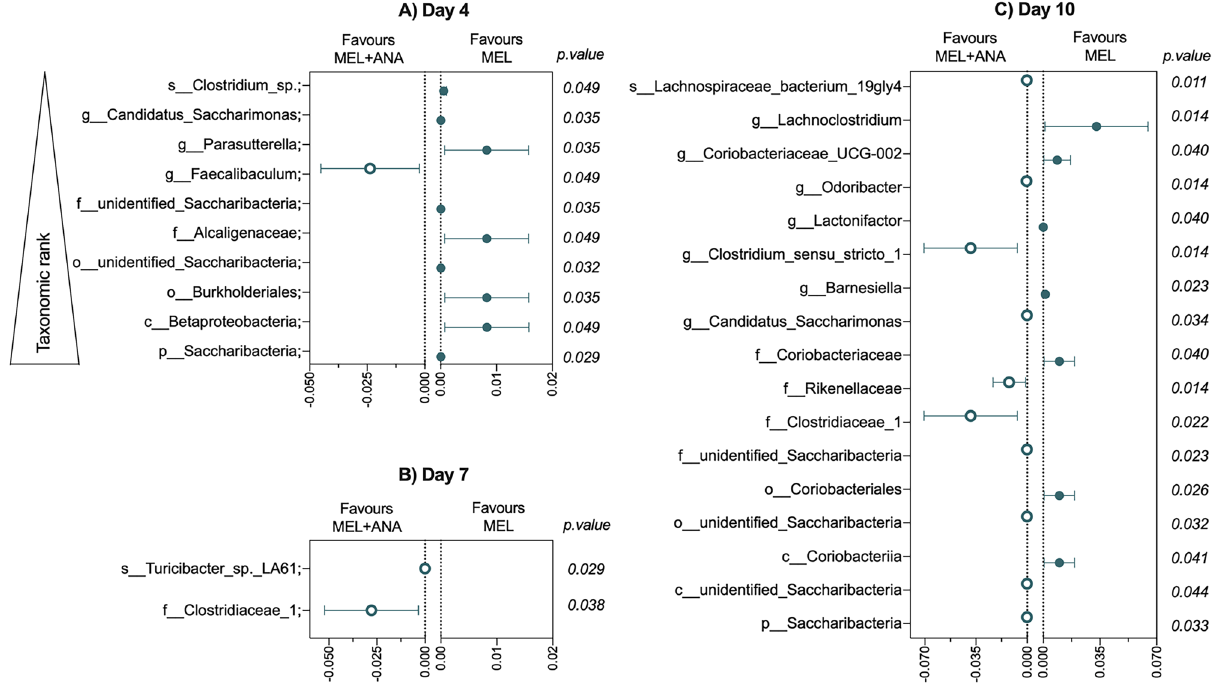
Figure 5. Anakinra promotes commensal stability and controls pathogen expansion. Melphalan alone depleted key commensal microbes and caused expansion of pathogens at day 4 ( A ), 7 ( B ) and 10 ( C ), each of which were minimized by anakinra. Data show median difference between groups (median ± 95% CI). All statistical analyses for microbiota data are outlined in supplementary